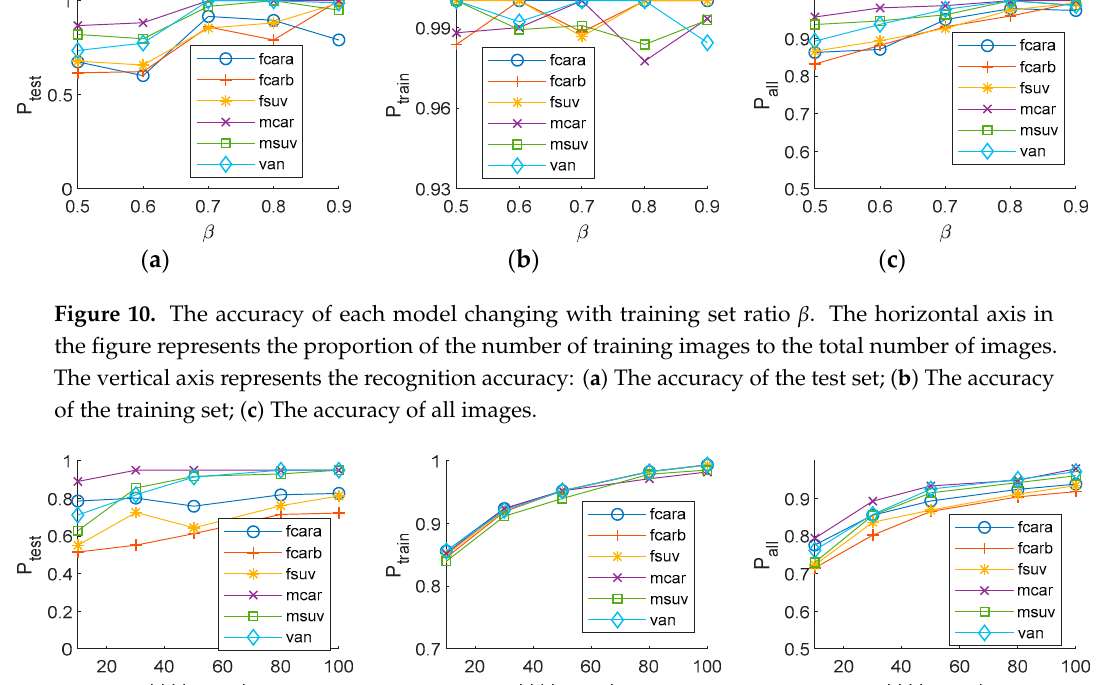
Figure 11. The accuracy of each model changing with the number of hidden nodes in CNN. The horizontal axis in the figure represents the hidden nodes in CNN. The vertical axis represents the recognition accuracy: ( a ) The accuracy of the test set; ( b ) The accuracy of the training set; ( c ) The accuracy of all images.